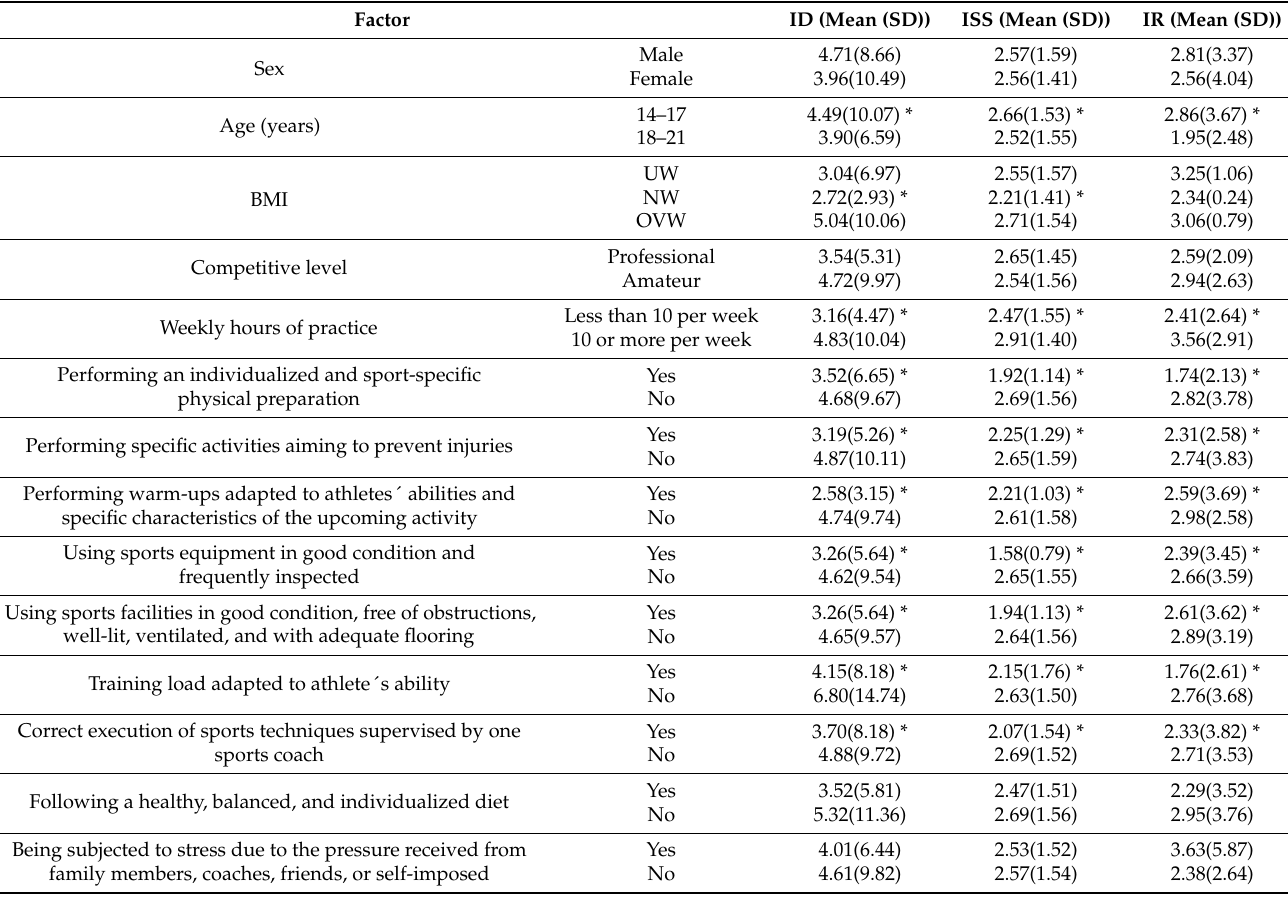
Table 3. Injury duration, injury severity score, and injury rate as a function of different factors and